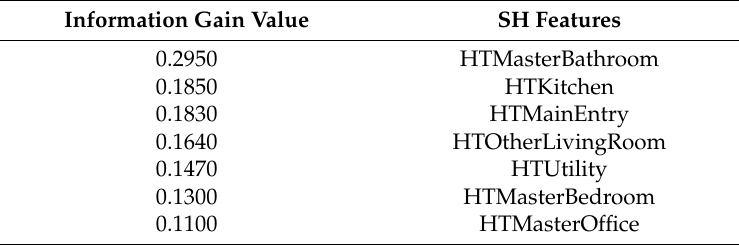
Table 17. InfoGain method predictions for indoor formaldehyde in IAQ 2